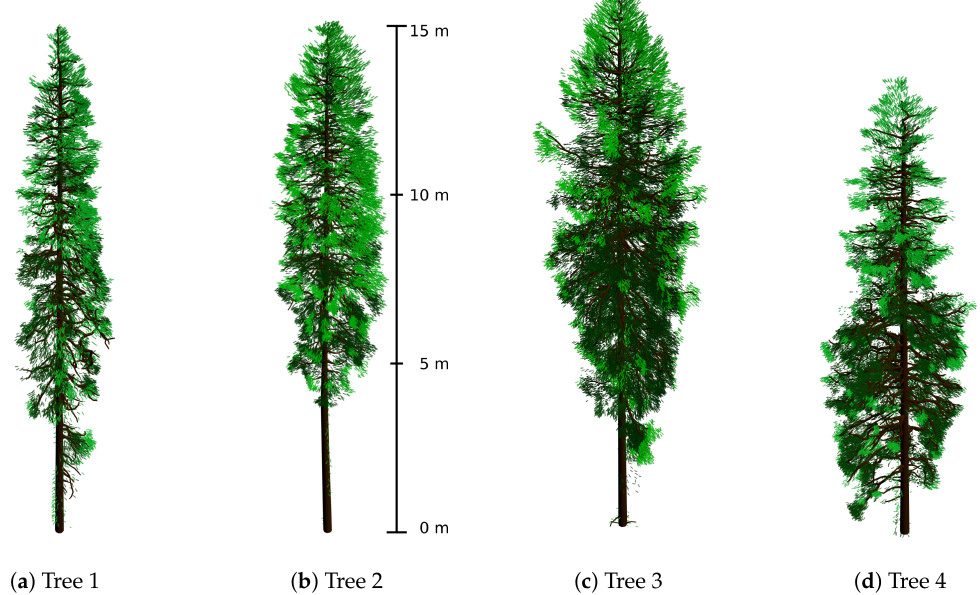
Figure 6. Four individual Norway spruce tree 3D representations reconstructed from TLS data point clouds using complex needle shoots. Colour rendering was done in the Blender software (www.blender.org), showing wood components in brown, newest needle shoots in light green, and older shoots in dark green